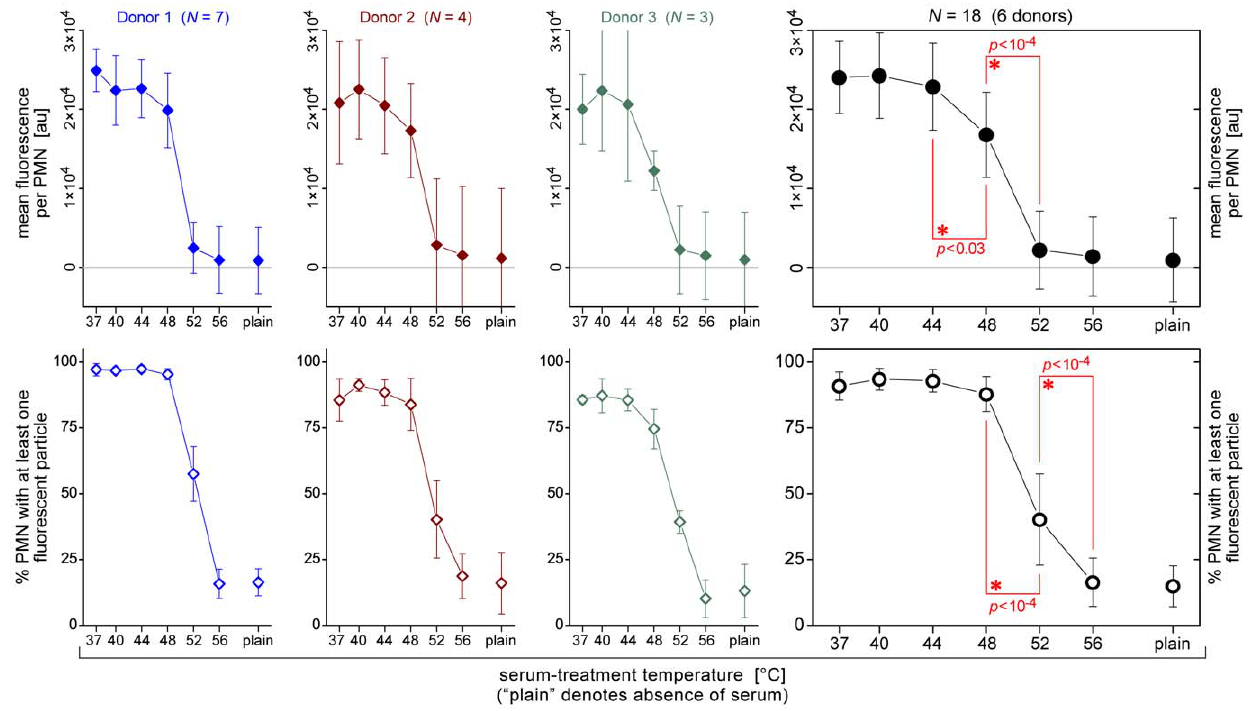
Figure 7. Summary of the FCM assessment of interactions between neutrophils (PMNs) and fluorescent zymosan particles in suspension as a function of serum heat treatment. The first three columns depict example data obtained with neutrophils and autologous sera from three different, healthy donors. The rightmost column summarizes the results for a total of 6 donors. Values are block-centered means 6 SD.